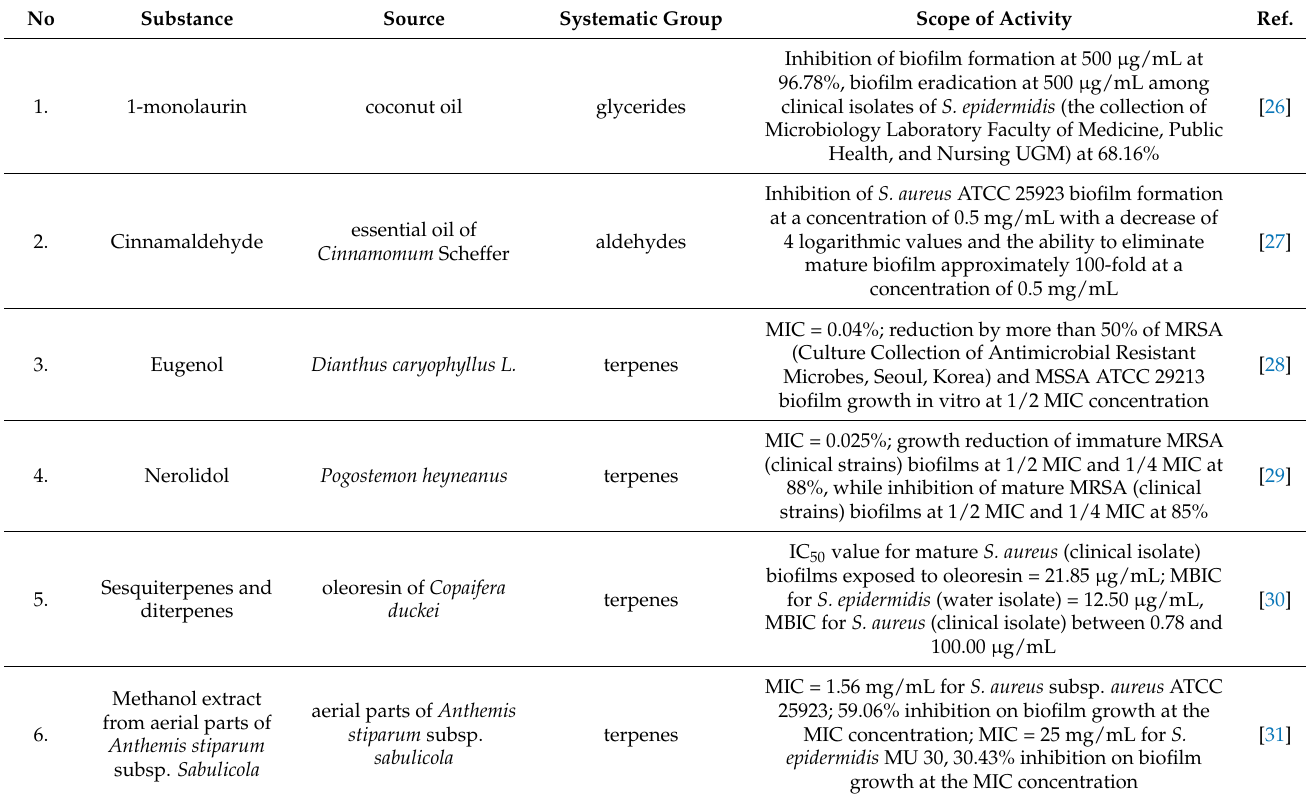
Table 1. Plant-derived antimicrobial substances with antibiofilm